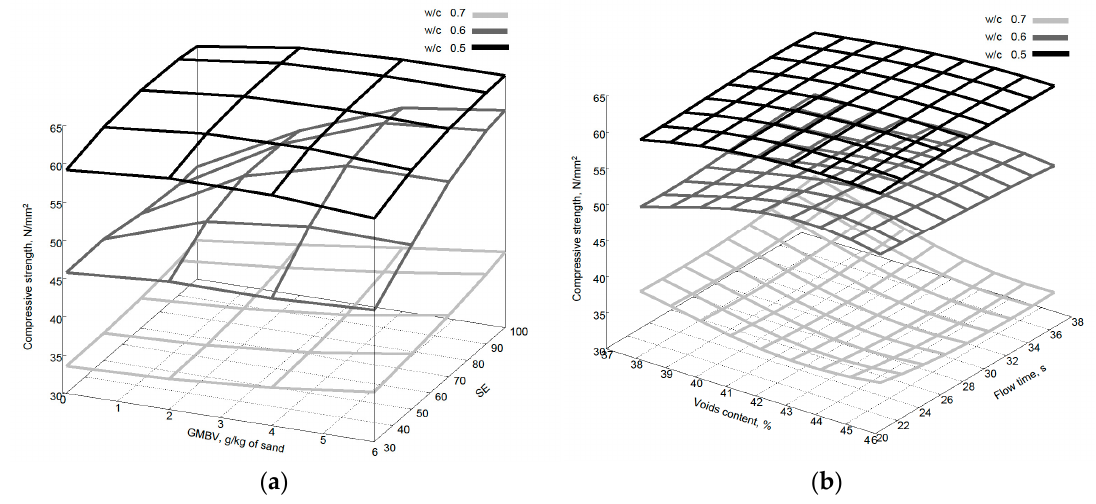
Figure 13. Variation of compressive strength predictions with ( a ) change of SE and GMBV and ( b ) change in voids content and flow time.